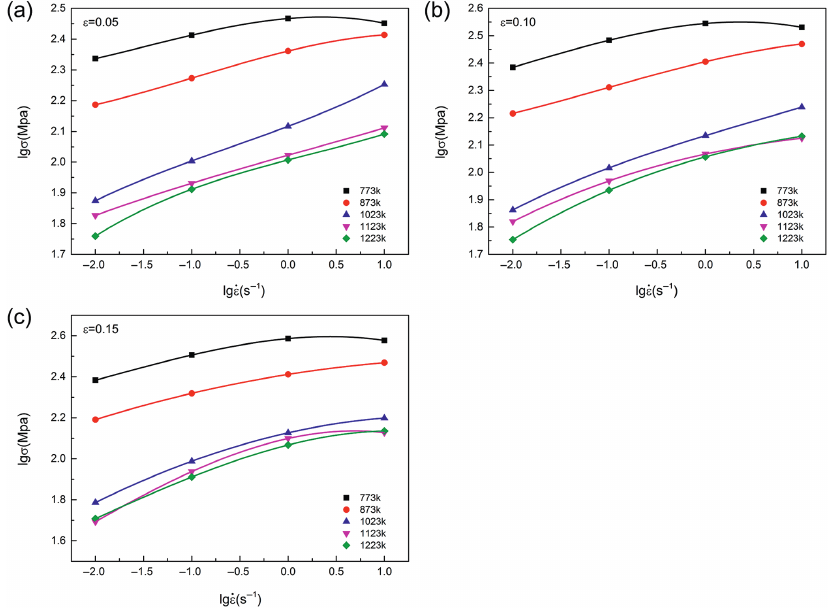
Figure 5: The relationships between stress and strain rate in lg scale at different deforming temperatures and true strains (a) ε = 0.05, 773 – 1,223K, (b) ε = 0.10, 773 – 1,223K and (c) ε = 0.15, 773 – 1,223K.